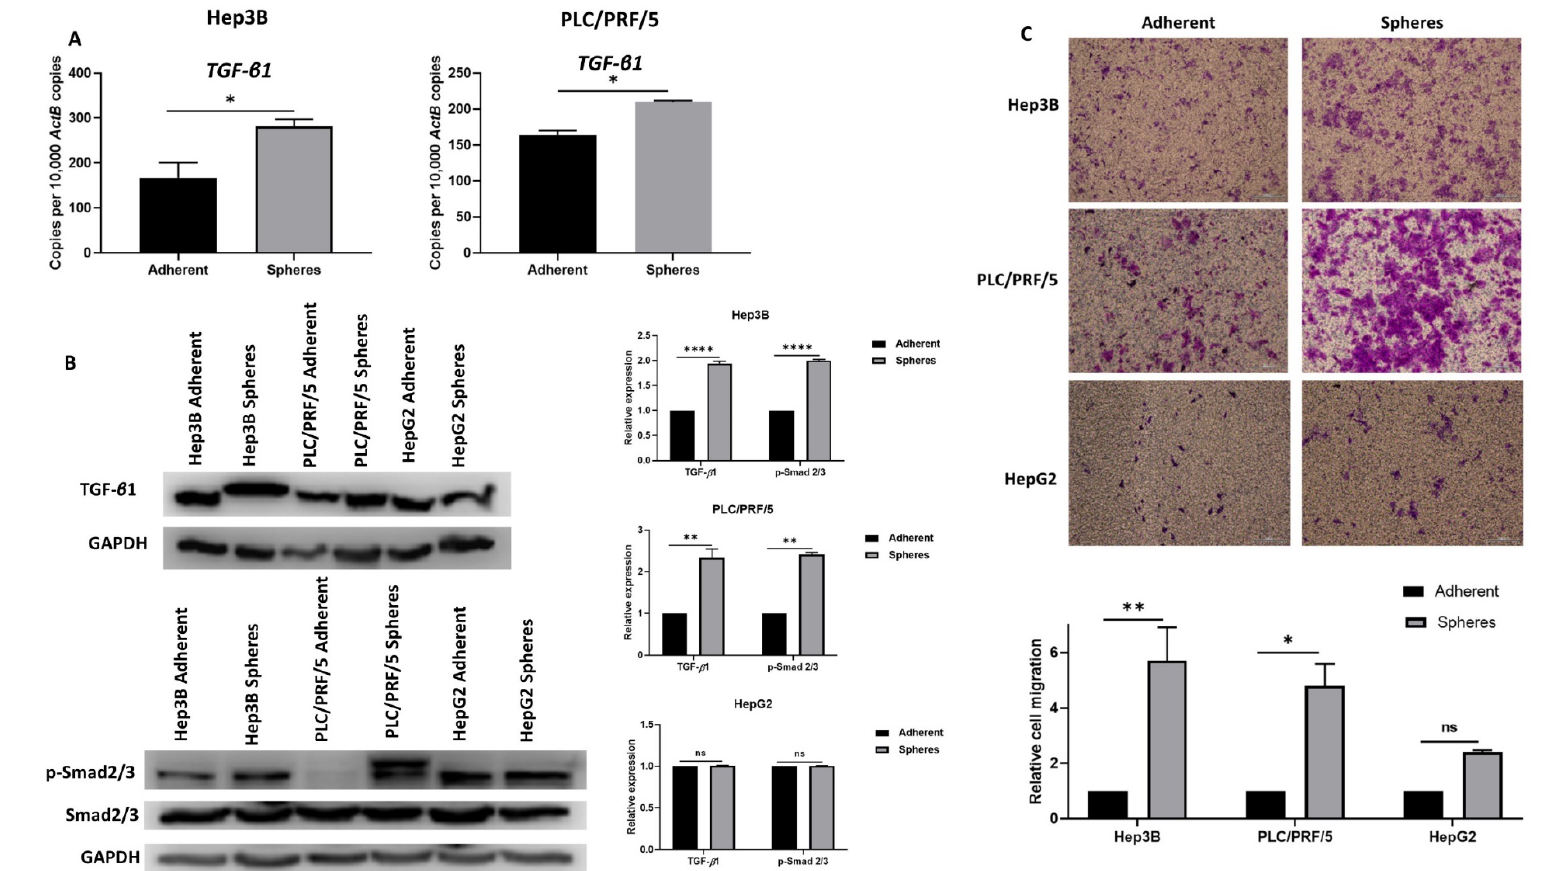
Figure 5. Human HCC-derived spheres exhibit mesenchymal phenotype. ( A ) qRT-PCR demonstrated an upregulation of TGF- β1 in Hep3B and PLC/PRF/5 -derived spheres compared to adherent cells. ( B ) Western blot analysis revealed an upregulation of TGF- β1 and p -Smad2/3 in Hep3B and PLC/PRF/5-derived spheres compared to adherent cells and no upregulation of TGF- β1 and p -Smad2/3 in HepG2-derived spheres compared to adherent cells. GAPDH was the loading control. Detailed information about Western Blot can be found at supple- mentary materials. ( C ) Transwell migration assay demonstrated higher motility of human HCC-derived spheres compared to adherent cells (scale bar = 500 µm). The number of motile cells on the transwell membrane was quantified by measuring the absorbance of Crystal Violet staining. ( n = 3, * p < 0.05, ** p < 0.01, **** p < 0.001, ns: not significant).